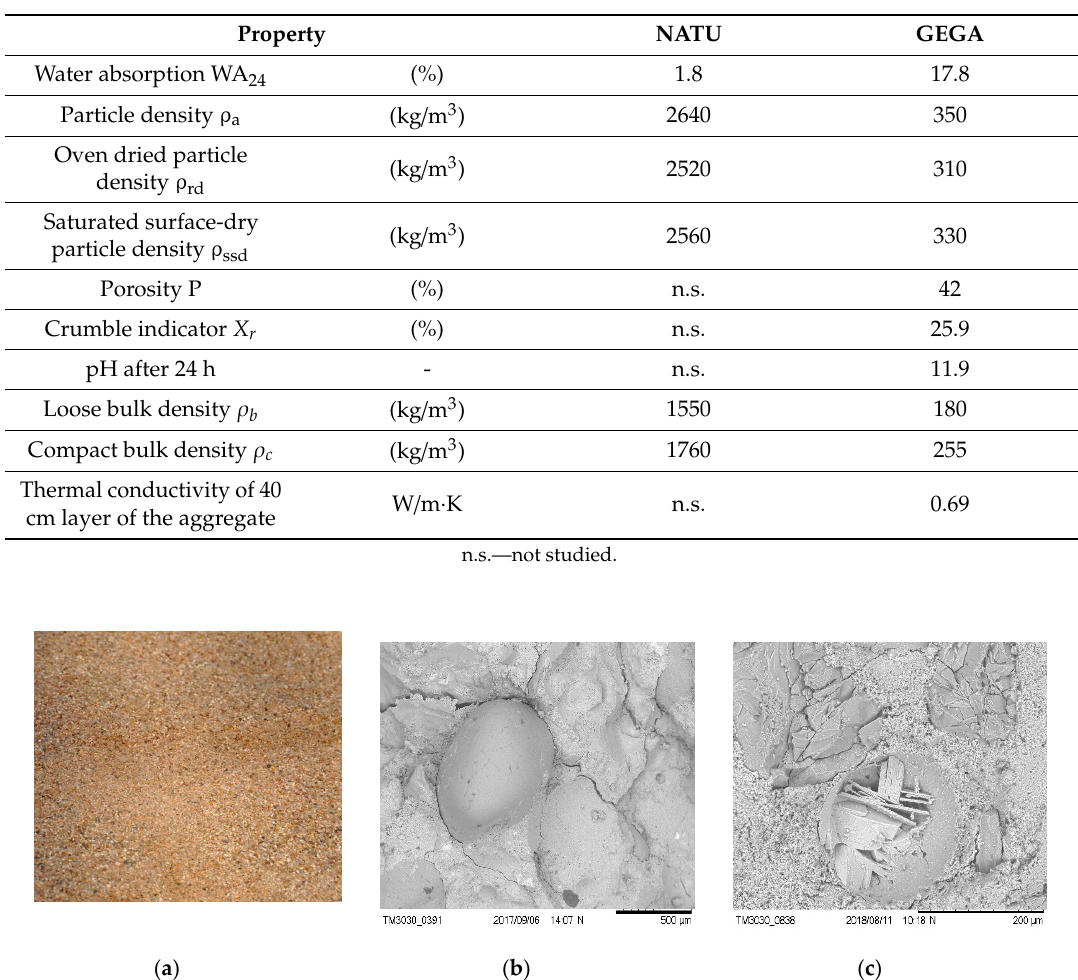
Table 3. Physical properties of the aggregates.